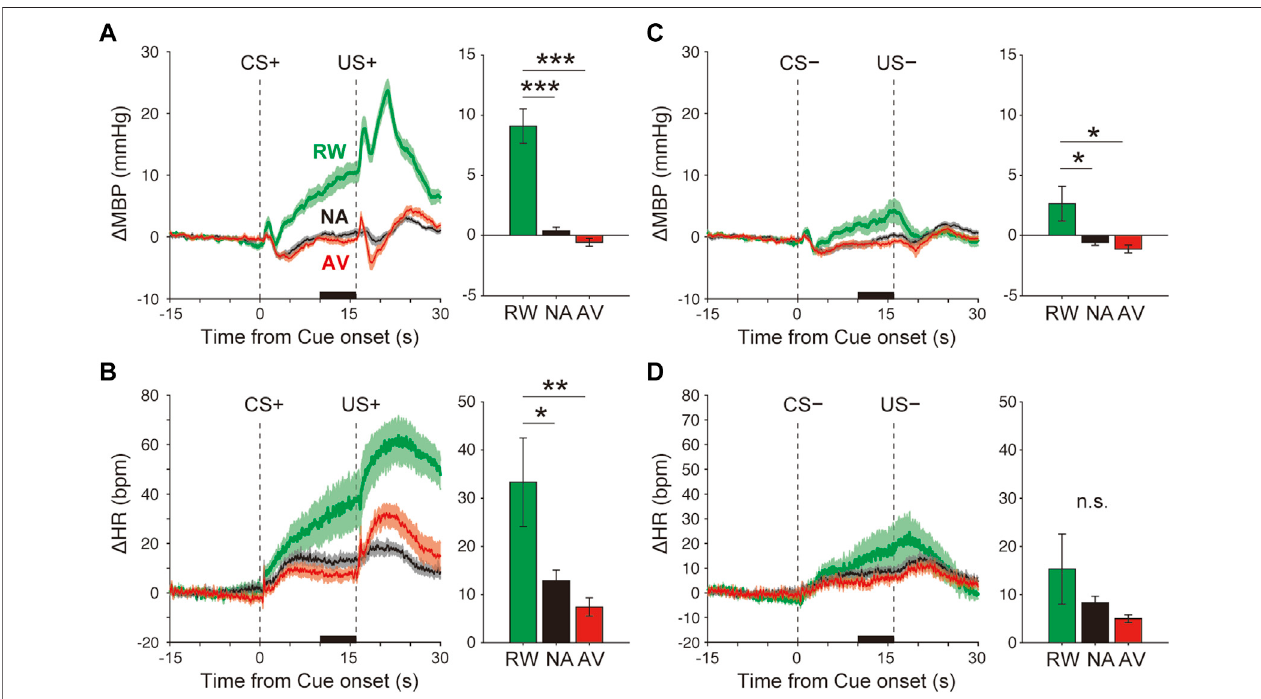
FIGURE2| BloodpressureandheartrateresponsesduringthePavlovianconditioningtask. (A – B) Averageresponsesof Δ MBP (A) and Δ HR (B) toCS+andUS+ during the reward (RW; green lineand bar), neutral (NA; black line and bar), and aversive (AV; red line and bar) condition blocks. Lines and shadows indicate the mean ± standard error. The thick black line on the X -axis indicates the time window for a quantitative analysis. (C – D) Same as A – B , but during CS − and US − . * p < 0.05, *** p < 0.001, one-way analysis of variance with a Tukey – Kramer post hoc test, and n = 10